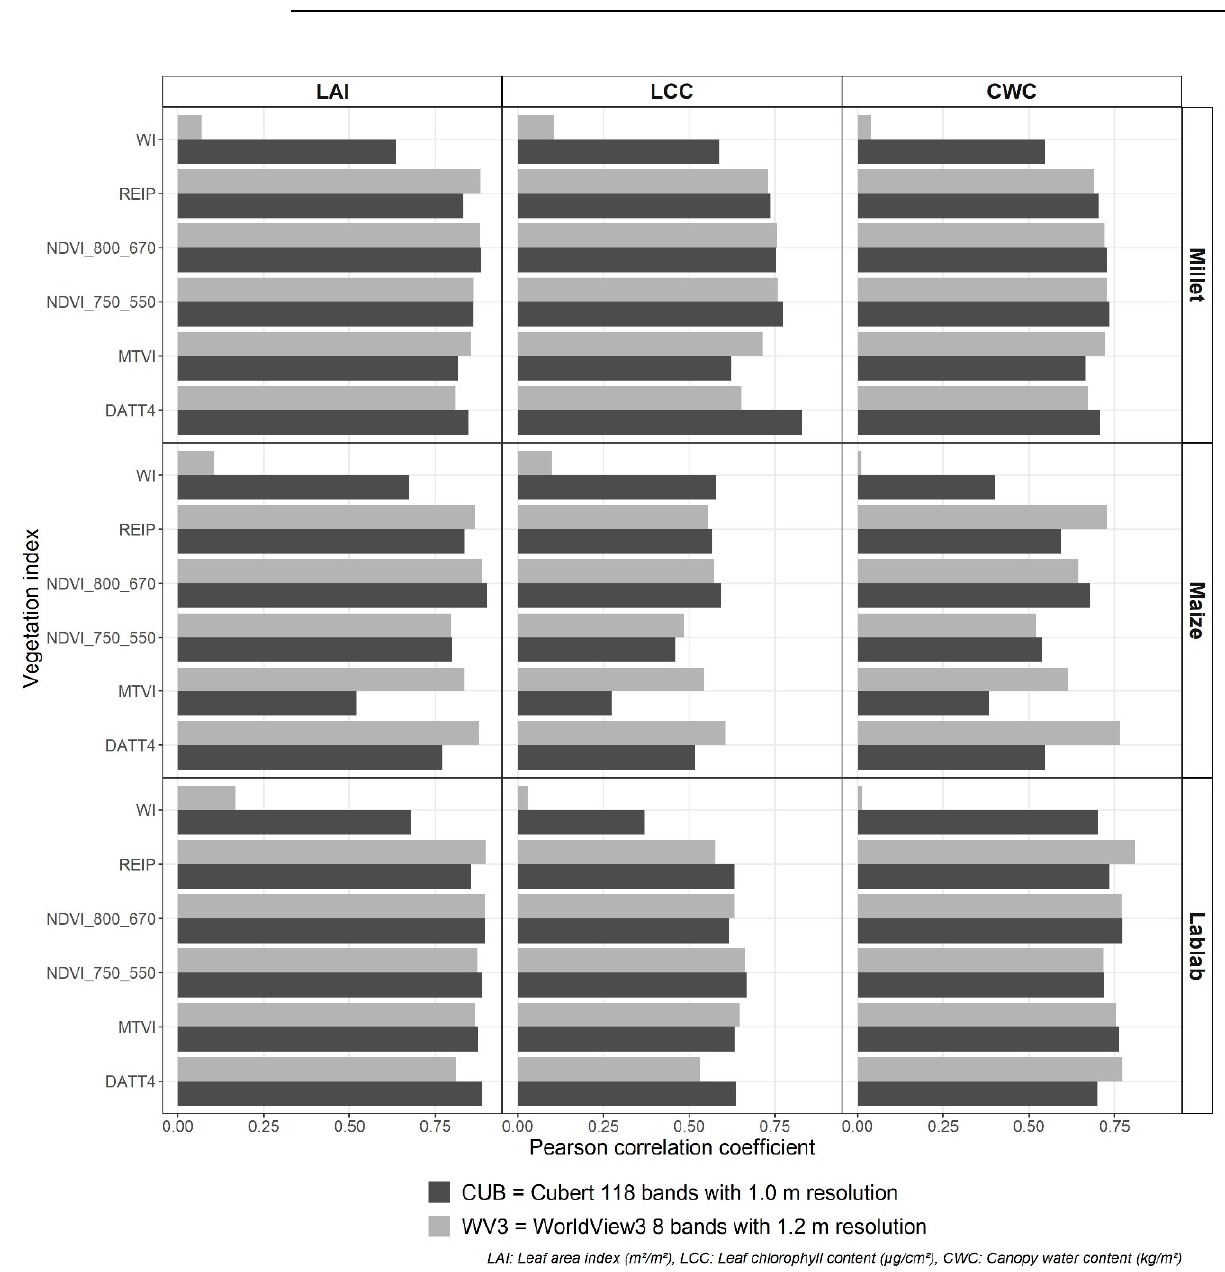
Figure A1. Correlation between vegetation indexes from two remote sensing data Cubert (black) and WorldView3 (grey) and crop vegetation parameters leaf area index (LAI), leaf chlorophyll content (LCC), and crop water content (CWC) for finger millet, maize, and lablab.